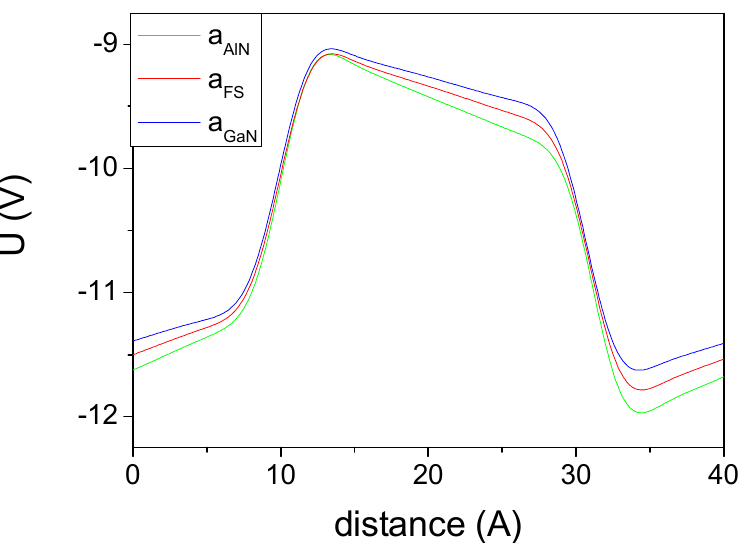
Figure 4. Double averaged electric potential profiles, obtained for 8AlN-8GaN atomic layers super- lattice. The line represents: AlN—structure strained to AlN, a lattice constant; FS—freestanding lat- tice; GaN—structure strained to GaN, a lattice constant.